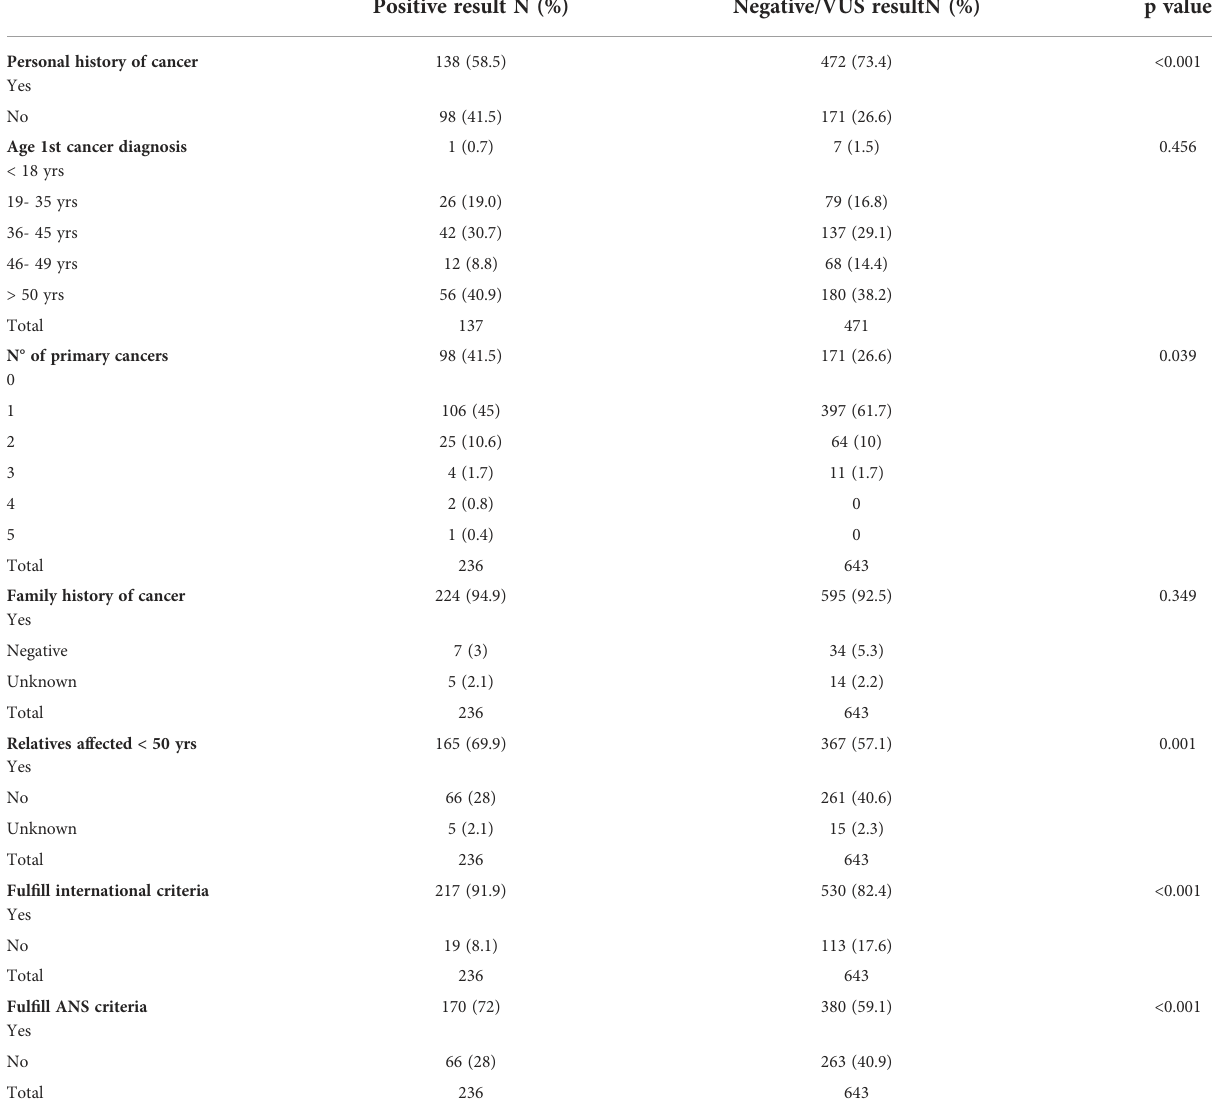
TABLE 1 Clinical pro fi le of the patients who underwent germline testing for